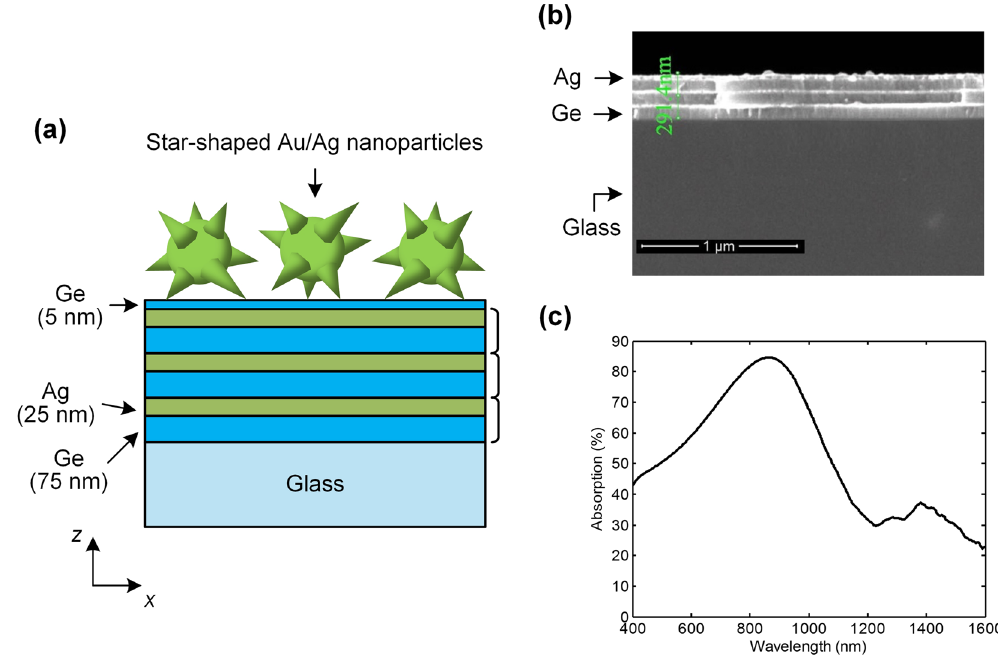
Figure 4. Characteristics of the HMM-based substrate. ( a ) Schematic diagram of the HMM-based substrate employing star-shaped gold/silver nanoparticles (not to scale). ( b ) SEM image of the bulk HMM substrate where the 5 nm-Ge layer and the star-shaped nanoparticles are absent. The three pairs of Ge-Ag multilayers can be clearly observed over the glass plate. ( c ) Absorption spectrum of the bulk HMM